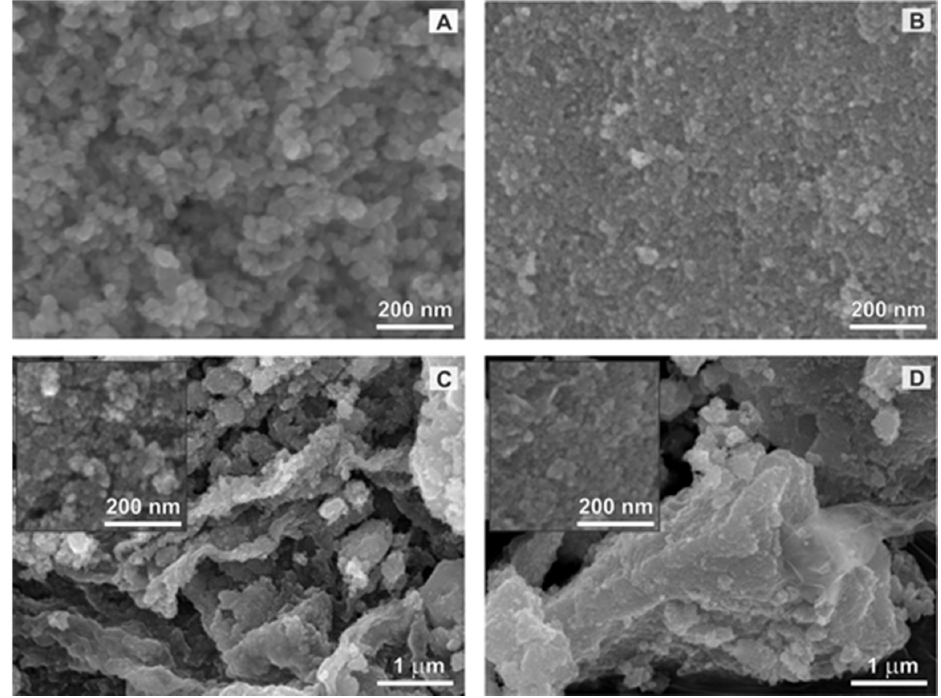
Figure 5 . SEM images. ( A ) commercial P-25; ( B ) synthesized TiO 2 ; ( C ) TiO 2 @rGO nanocomposite with 5 wt.% of rGO; ( D ) TiO 2 @rGO nanocomposite with 15 wt.% of